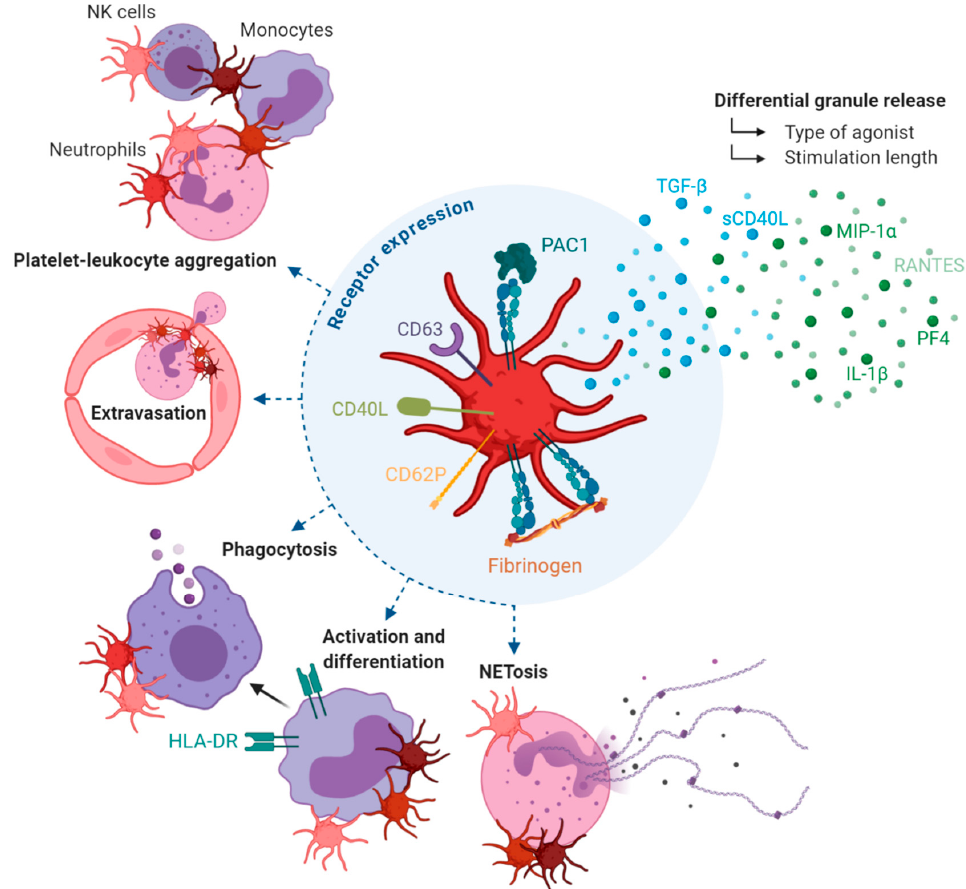
Figure 1. Platelets are complex immune cells that can induce a plethora of inflammatory responses.